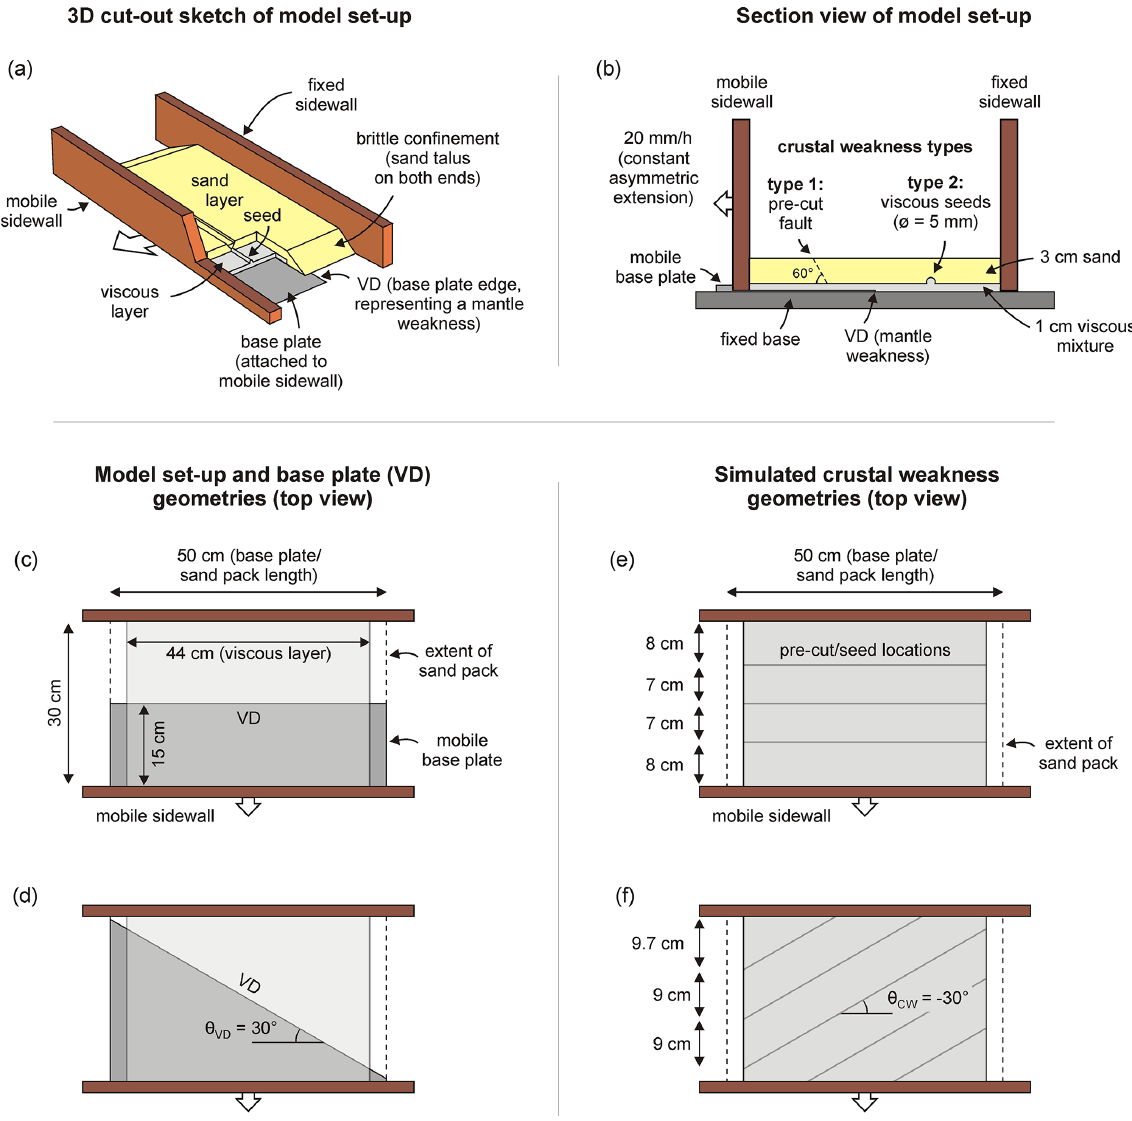
Figure 1. Model set-up. (a) 3D sketch of general set-up. VD: velocity discontinuity representing a weakness (e.g. a shear zone) in the strong upper mantle. (b) Section view depicting standard model layering and the two types of crustal weaknesses (pre-cuts and viscous seeds). (c–d) Model set-up and base plate geometries shown in map view. (c) Base plate configuration for main Series 1 (with VD parallel to model axis or θ VD = 0 ◦ ). (d) Base plate configuration for main Series 2 (with VD 30 ◦ oblique to model axis or θ VD = 30 ◦ ). (e–f) Examples of crustal weakness geometries at the top of the viscous layer, shown in map view. (e) Model axis-parallel crustal weaknesses ( θ CW = 0 ◦ ). (f) Crustal weaknesses − 30 ◦ oblique to the model axis ( θ CW = − 30 ◦